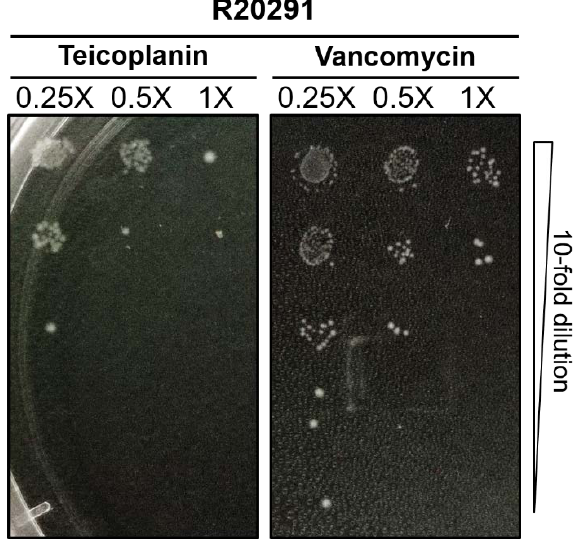
Figure 1. Antibacterial activity at sub-MICs of antibiotics using spot assay. A representative strain of C. difficile R20291 was attained to 0.1 OD 600 in BHIS (brain heart infusion supplemented with 0.1% sodium taurocholate) medium supplemented with 0.25×, 0.5×, 1× MICs of teicoplanin or vancomycin. After 24-h incubation, cultures were 10-fold serially diluted and spotted onto BHIS agar plates, and plates were photographed following 24 h anaerobic incubation at 37 °C. Table 1. Minimal inhibitory concentrations for teicoplanin and vancomycin for 30 C. difficile strains.